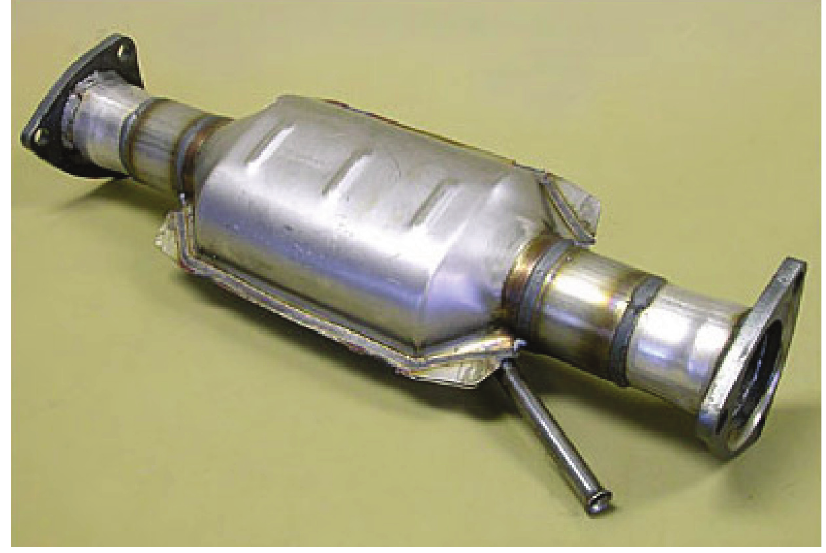
Figure 3: A completed under-floor catalytic converter as part of the exhaust system (source: Anonymous 2, 2009: